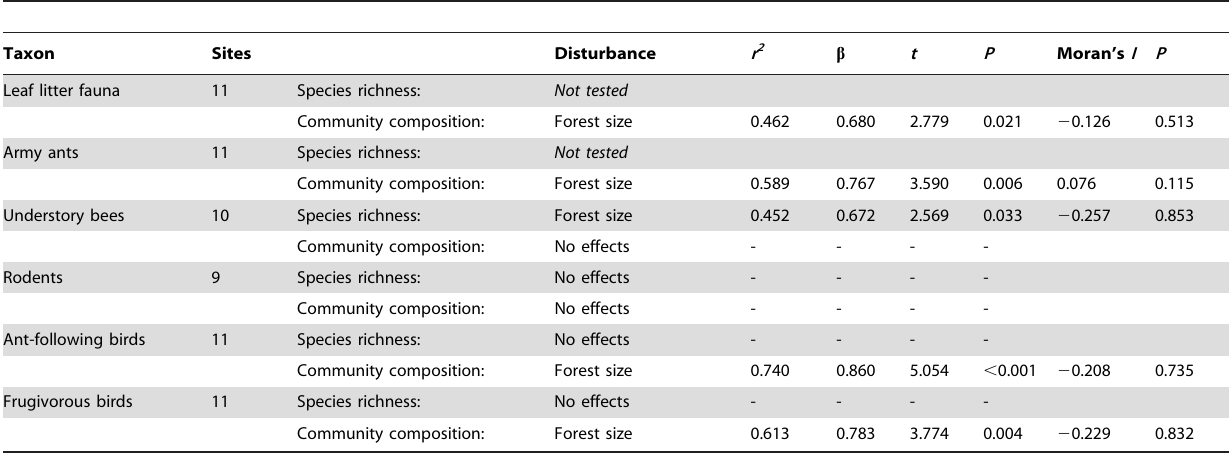
Table 2. Effects of forest size and selective logging on species richness and community composition of six animal taxa in Kakamega